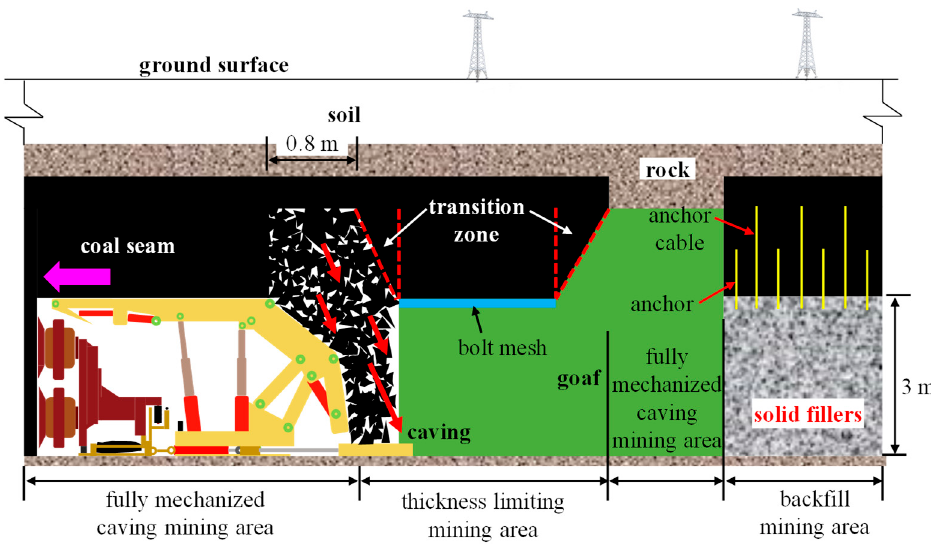
Figure 8. Schematic diagram of the combined mining scheme adopted in working face 1110.